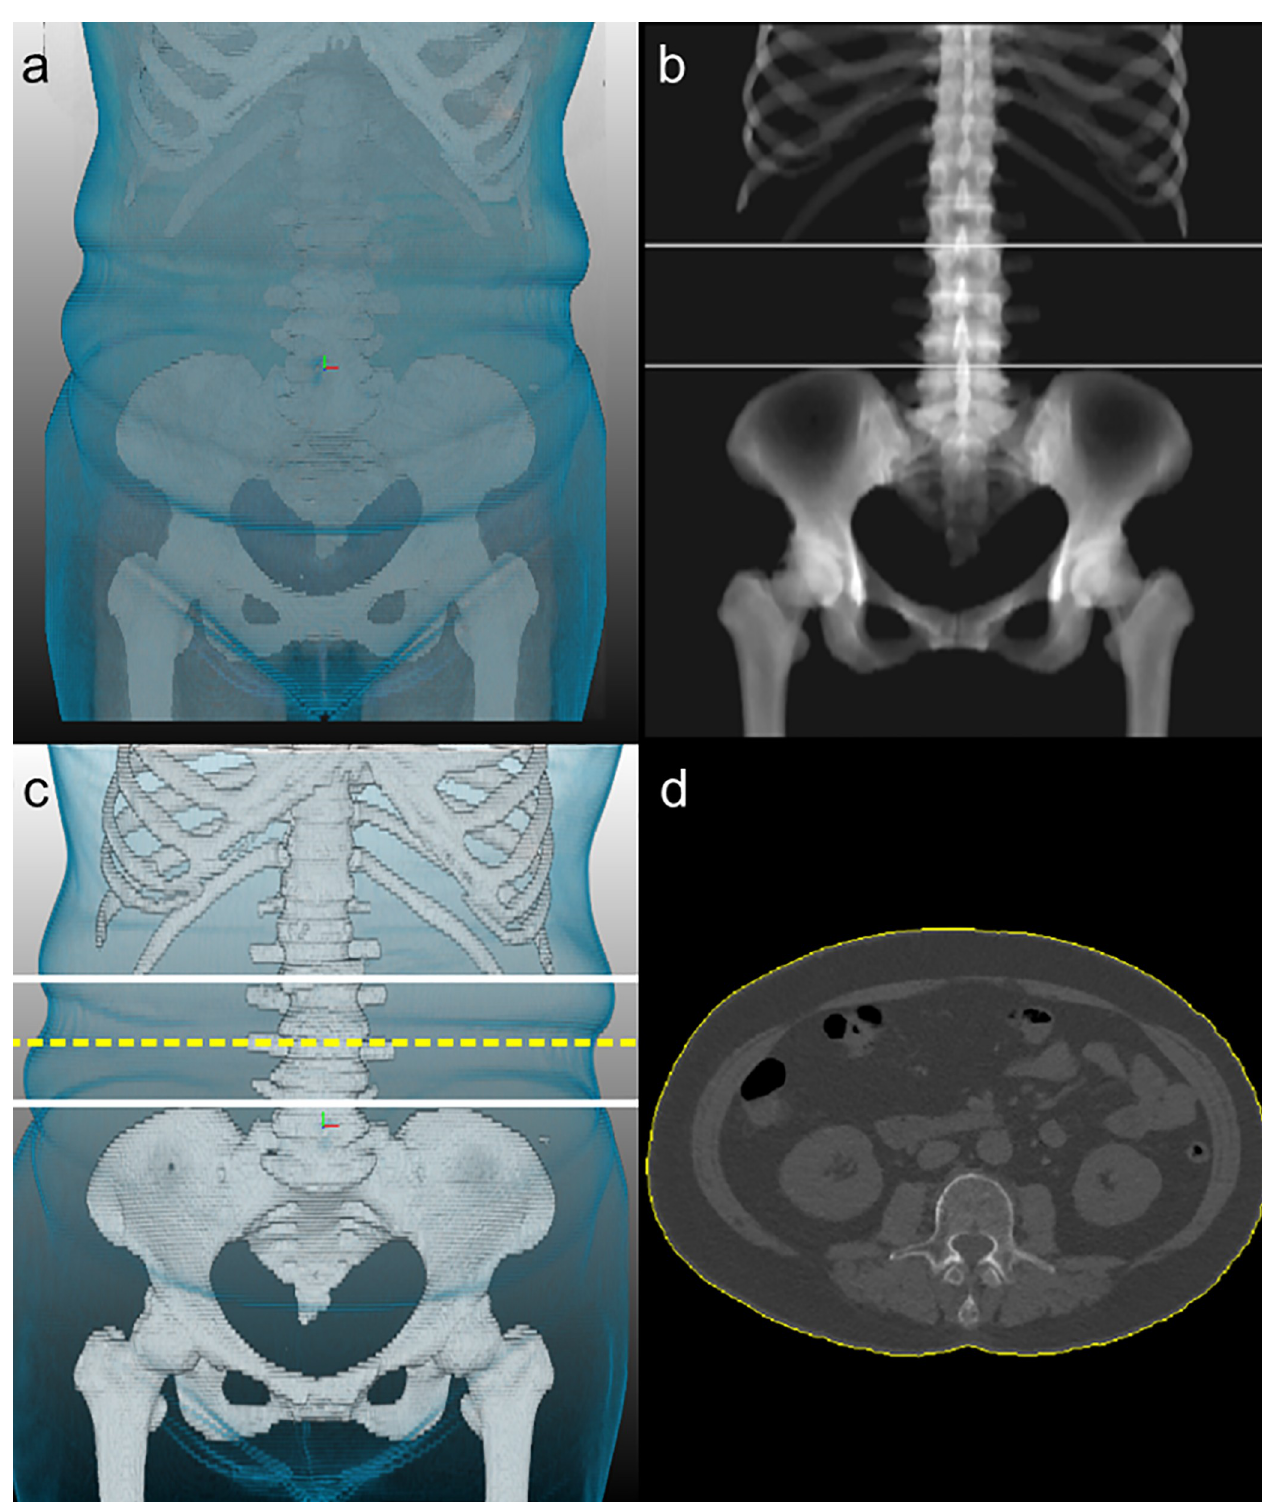
Fig 1. Example of a CT measurement of waist circumference using the fully automated body segmentation algorithm. (a) 3D display of skin and bone, (b) identification of the z-axis level of the lowest rib margin and the highest iliac crest margin, (c) determination of the midpoint z-axis level (dashed line) between the lowest rib margin and the highest iliac crest margin, (d) extracted body perimeter (yellow line) in the selected axial image based on 3D skin segmentation.